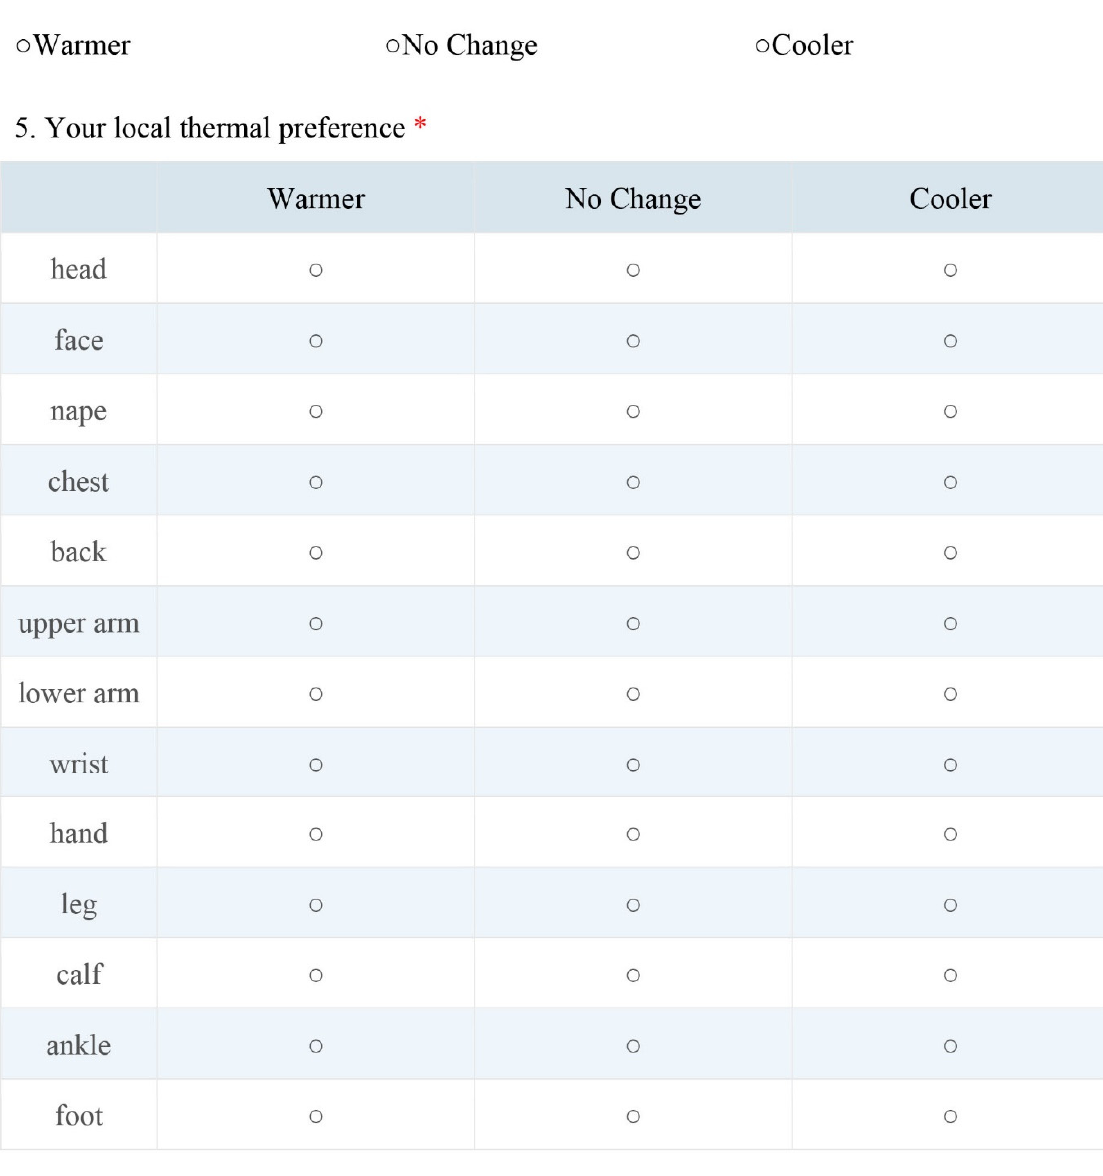
Figure A3. Thermal preference questionnaire, part two.